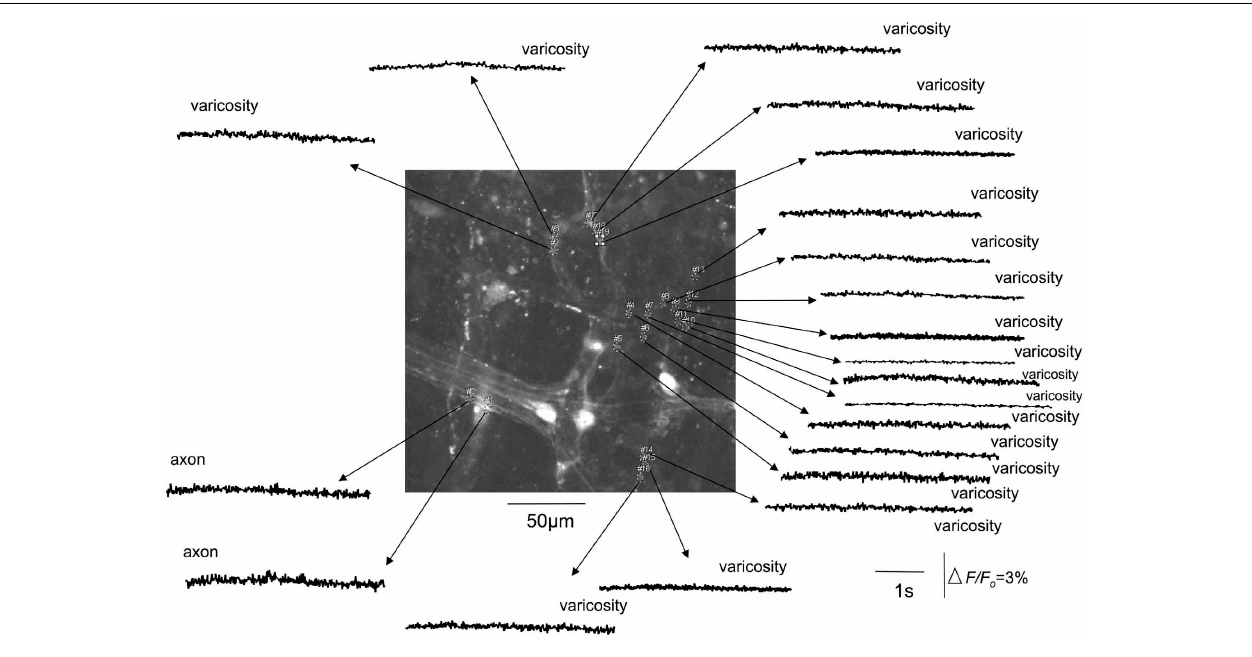
relative changes in fluorescence were reported as delta F / F o , where delta F stands for the change in fluorescence intensity and F o for the baseline level.